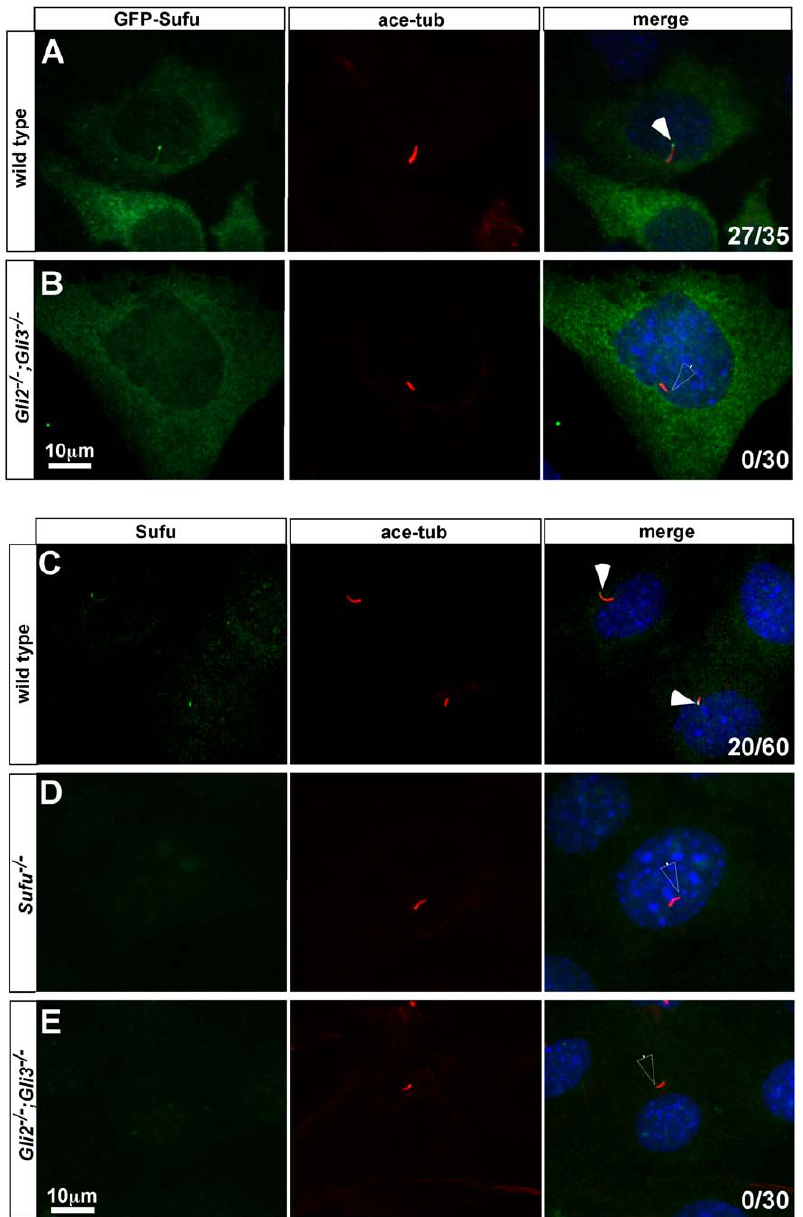
Figure 5. Sufu ciliary localization depends on Gli proteins. (A, B) GFP-Sufu is localized to the cilia in wild type (A), but not in Gli mutant cells. (C–E) Endogenous Sufu is localized to the tips of cilia in wild type (C), but not in Gli2;Gli3 double mutant cells (E). The specificity of the Sufu antibody is confirmed by the loss of Sufu signal in the cilia of Sufu mutant MEFs (D). The localization of over-expressed GFP-Sufu is visualized with an anti-GFP antibody (greeninA,B), whereas endogenousSufuisvisualizedwithananti-Sufuantibody(greeninC–E). Cilia arelabeledwithacetylatedtubulin(red)andnucleiare stained with DAPI. In the merged images, filled arrowheads indicate GFP or Sufu signal at the tips of the cilia, unfilled arrowheads indicate the tips of cilia without GFP-Sufu or Sufu accumulation. Numbers at the lower-right corners of each image indicate numbers of cells with ciliary localization of GFP-tagged proteins over total numbers of transfected cells (A, B), or the number of cells with ciliary localization of Sufu over total number of ciliated cells (C, E).